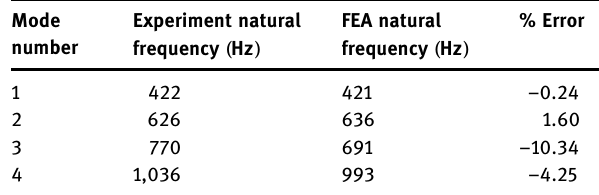
Table 5: Natural frequencies correlation